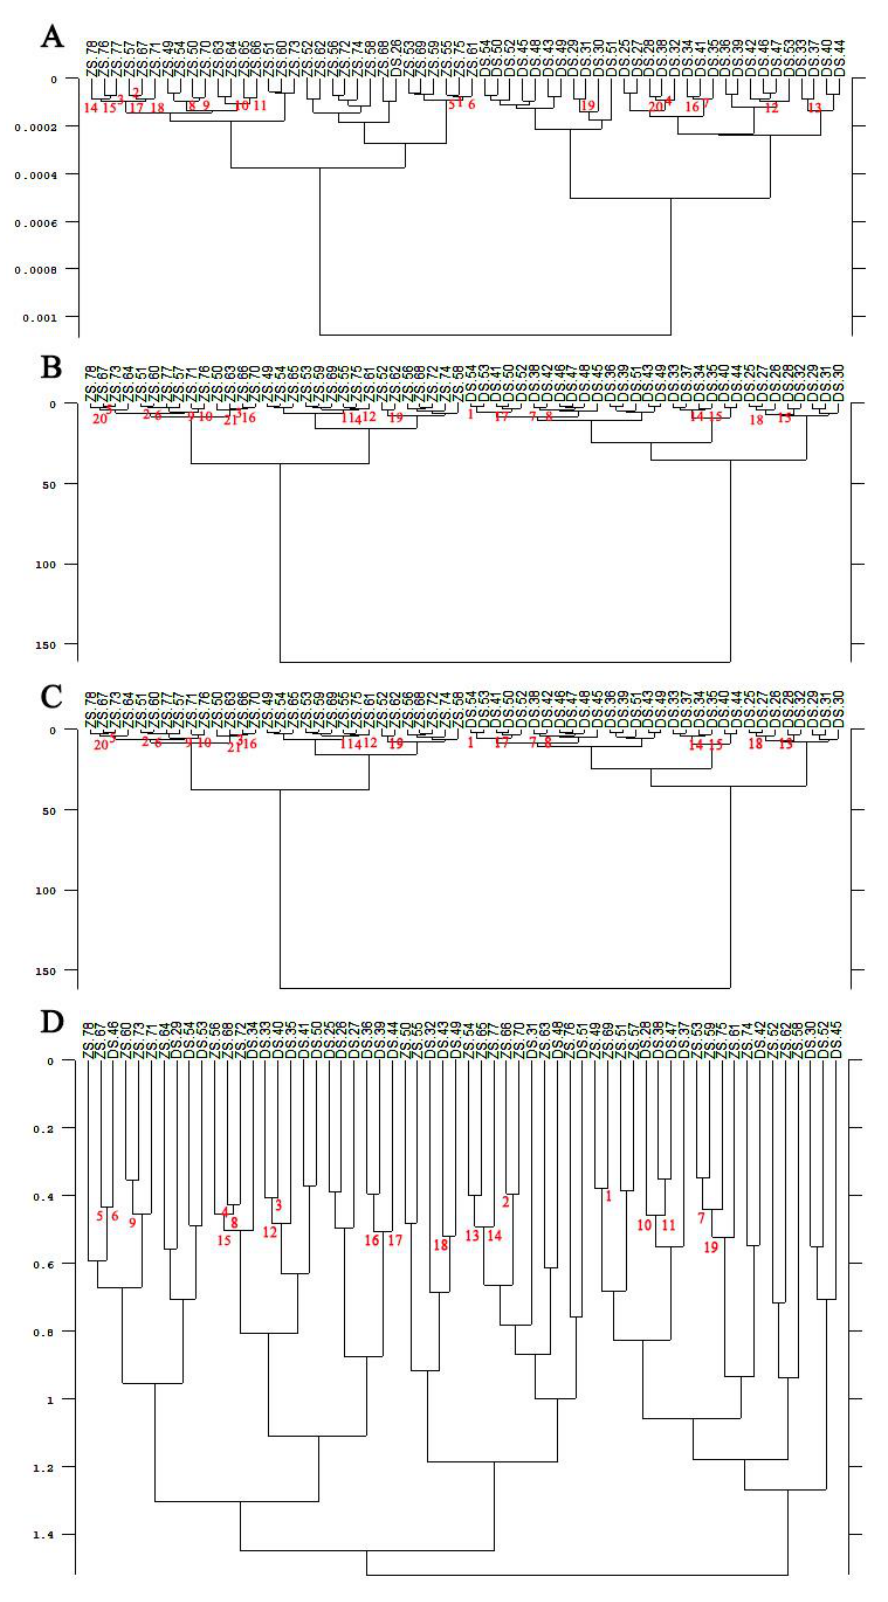
Figure 5. Tree diagram of pear fruit clustering analysis from the Meixian test site. ( A ) Standard algorithms; ( B ) First range calibration methods; ( C ) Reproduction level normalization methods; ( D ) Factorial methods.